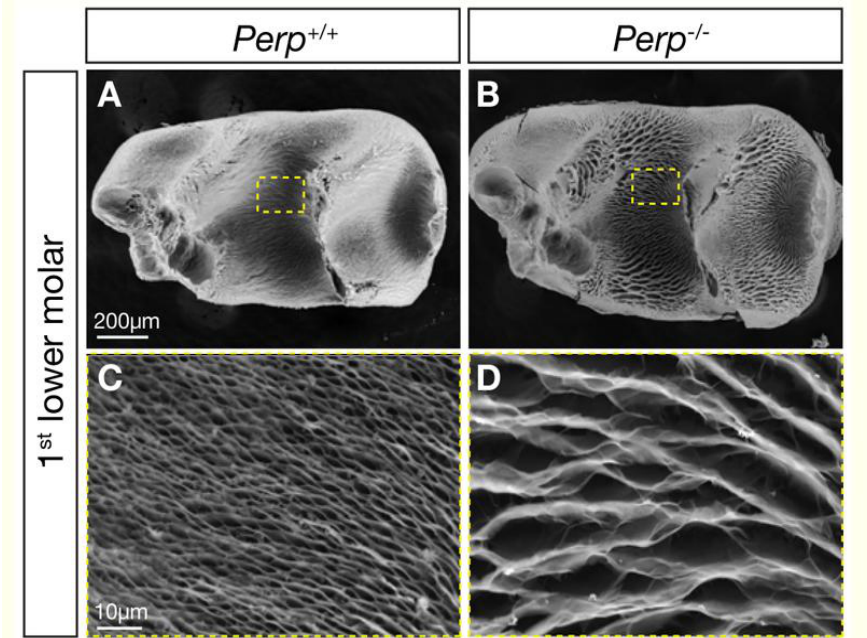
Figure 2. Scanning Electronic Microscope (SEM) analysis of teeth at postnatal day 2. (A, C) Low- magnification images of the enamel surface of the first lower molars from wild-type ( Perp +/+ ) and Perp -null ( Perp -/- ) mice. (B, D) Higher-magnification images of the boxed